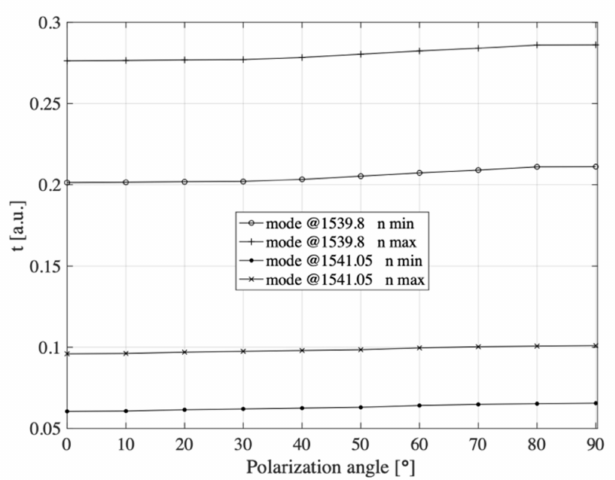
Figure 28. Characteristics of the cross-sensitivities of the P-TFBG sensor for changes in input light polarization angle χ measured for two selected cladding modes. Measurements were performed using the minimum tracking